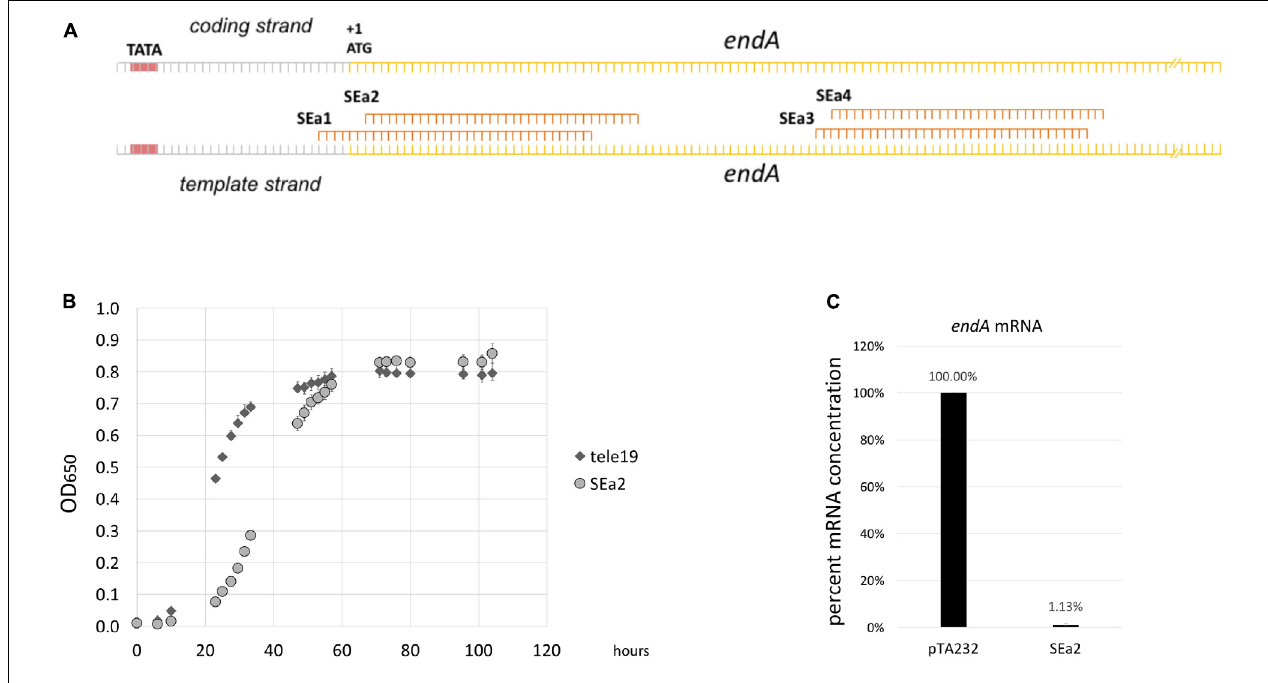
FIGURE 4 | CRISPRi against the endA gene results in reduced endA mRNA concentrations. (A) Location of crRNAs. Four different crRNAs (SEa1-SEa4) were designed against the endA transcription start site and beginning of the ORF. The promoter is indicated with a red box and TATA; the transcription start site is indicated with +1; the endA ORF is indicated in yellow and the ATG is also shown. TSS and the A of the ATG are identical, showing that the endA mRNA is leaderless. For a more detailed view see Supplementary Figure 1 . (B) Expression of crRNA SEa2 influences growth. Expression of crRNA SEa2 results in a severe lag phase (light gray circles, SEa2). As a control, a crRNA that does not bind any target in the cell was expressed (dark gray diamonds, tele19). (C) Reduction of endA mRNA concentrations upon expression of crRNA SEa2. qRT-PCR was performed to measure the concentrations of endA mRNA in wild type (column pTA232, cells HV30 × pTA232) and CRISPRi cells (column SEa2, cells HV30 × pTA232SEa2). The mRNA concentration in wild type cells was set to 100%. Repression with CRISPRi reduces the mRNA concentration to 1.1% ( ± 0.5) of that of the wild